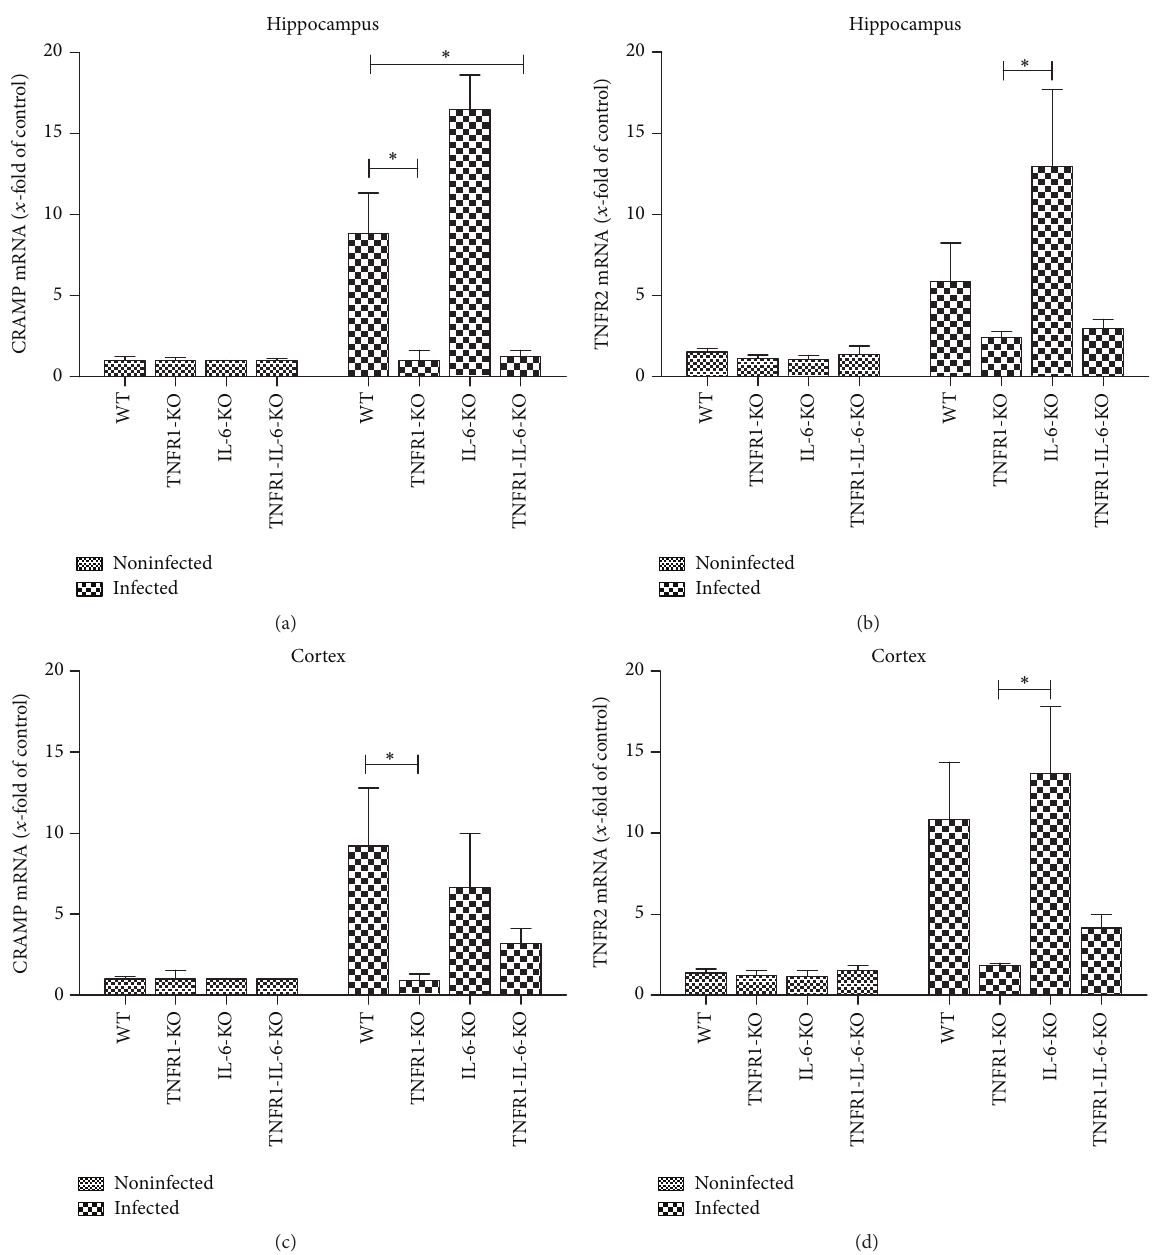
Figure 4: Expression of antimicrobial peptide CRAMP and TNFR2 after pneumococcal meningitis in hippocampus and cortex. 30 h after subarachnoid infection with Streptococcus pneumoniae , mRNA expression of CRAMP or TNFR2 was determined in the hippocampal formation (a and b) and cortex (c and d) from TNFR1-, IL-6-, or TNFR1-IL-6-KO and WT mice by real-time RT-PCR. Data were assessed from five independent experiments in duplicate. An asterisk indicates a significant difference between infected WT and infected TNFR1- or TNFR1-IL-6-KO mice as determined by ANOVA followed by Bonferroni test ( ∗ 𝑝 < 0.05